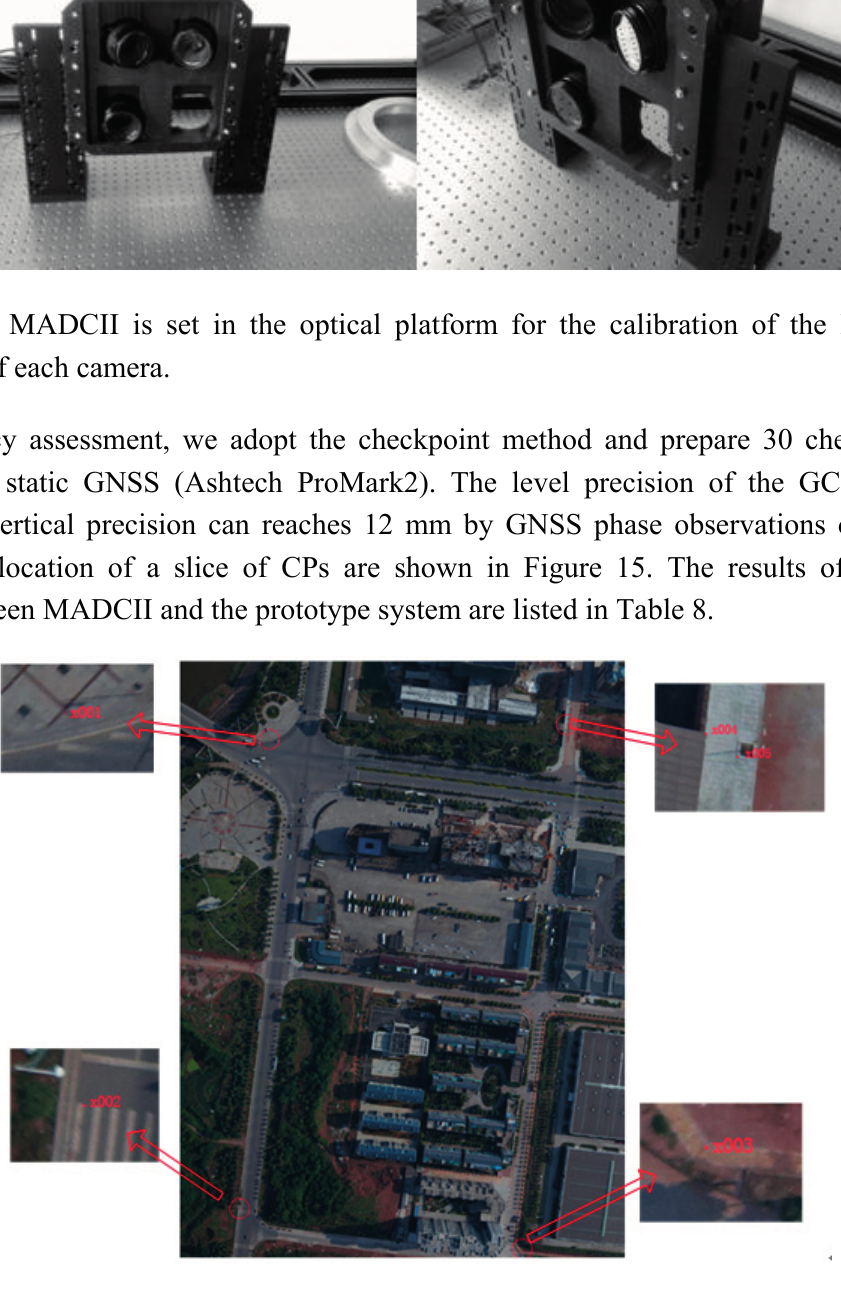
Figure 15. A slice of ground control